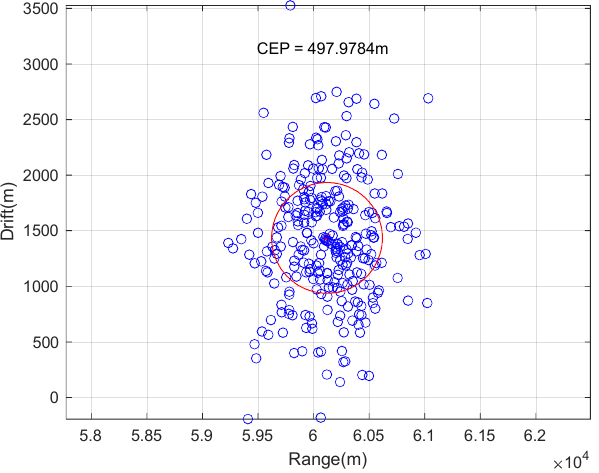
Figure 24. Guided Rocket Trajectories.